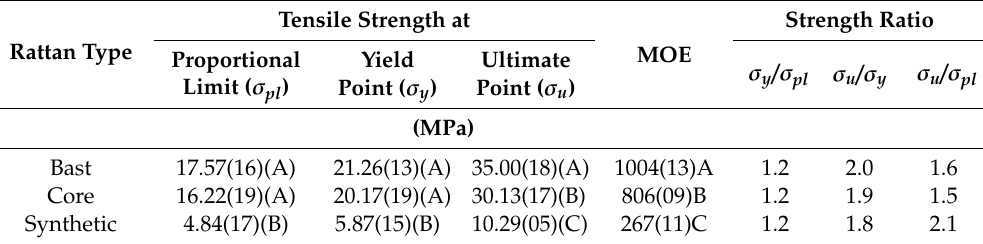
Table 3. Mean values of tensile strength and modulus elasticity (MOE) of rattan strips evaluated in test 1 and their mean comparisons for rattan type 1 .